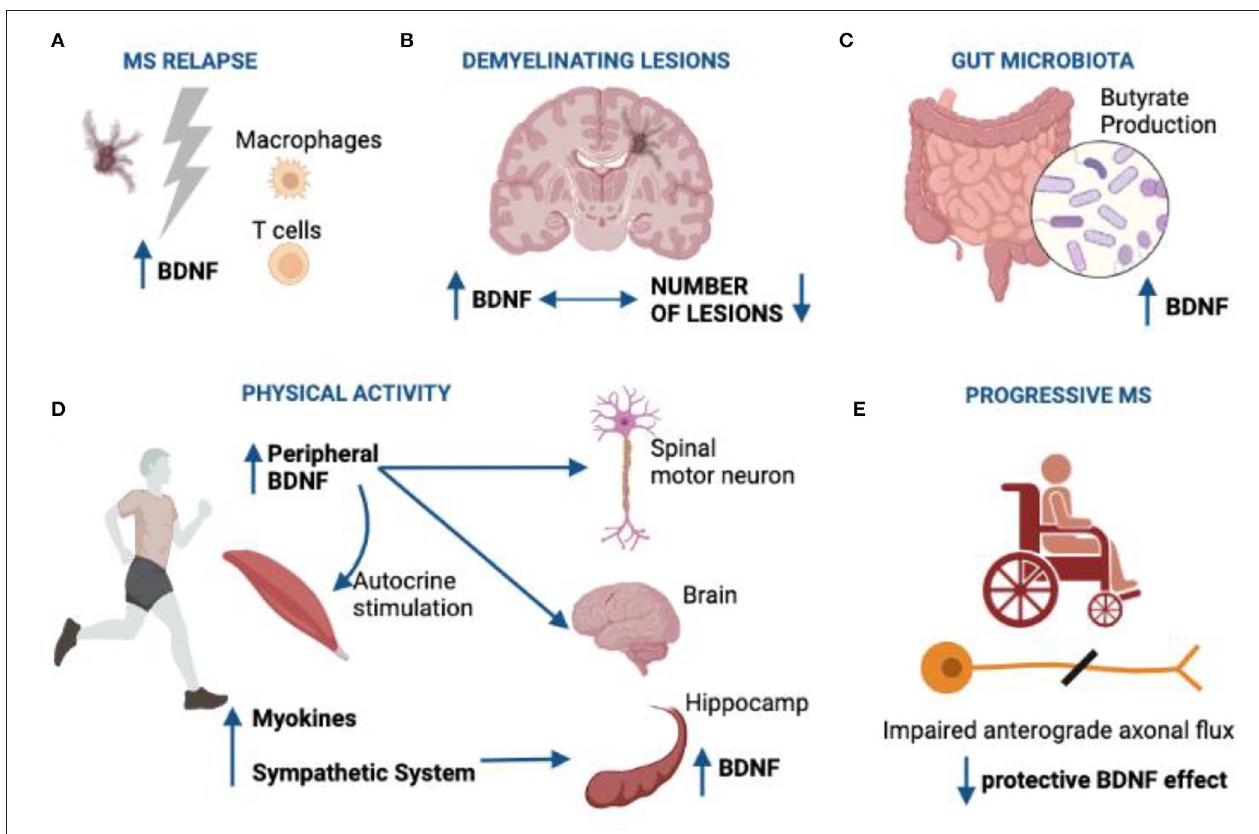
FIGURE 2 | Role of BDNF in multiple sclerosis. (A) BDNF is reduced in patients with MS although during the relapses, its production is enhanced by neurons, macrophages, and T cells; (B) BDNF levels are inversely correlated with the number of lesions evidenced by magnetic resonance imaging; (C) gut microorganisms producing butyrate are able to induce BNDF expression; (D) muscles are able to produce BDNF and myokines as well as they may stimulate sympathetic system. Peripheral BDNF may directly cross the BBB, thus explaining its effect on CNS. Also, it may serve as retrograde signal for the motor neurons of the spinal cord. Myokines such as irisin and sympathetic system may both stimulate the BDNF production in hippocamp; (E) in progressive multiple sclerosis, the impairment in anterograde axonal flux may lead to disrupted BDNF afflux in demyelinating lesions, thus reducing the protective role of BDNF. BDNF, brain-derived neuron factor; MS, multiple